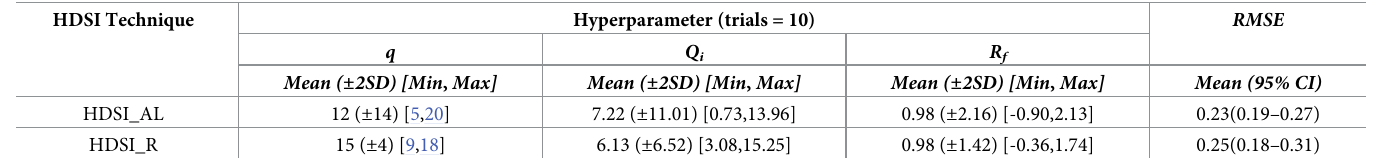
Table 2. Optimal region for